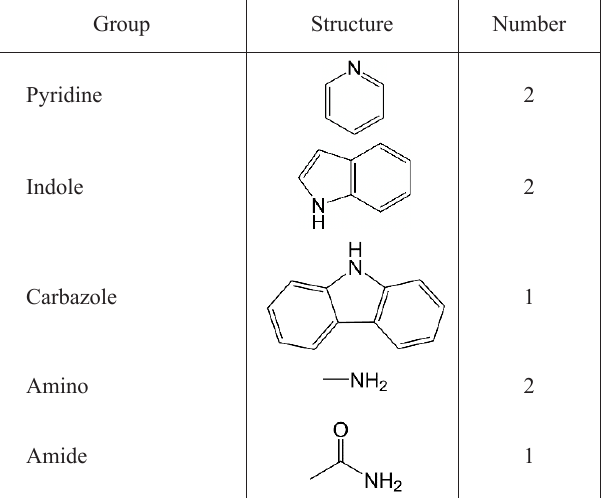
Table 3. Heteroatom-containing functional groups in Dachengzi oil shale kerogen molecular model Group Structure Number